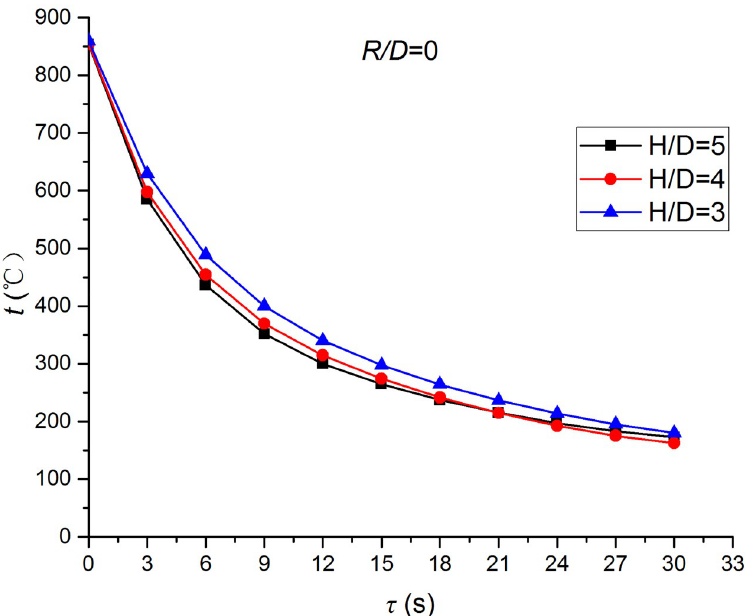
Fig 25. Surface temperature at R/D =